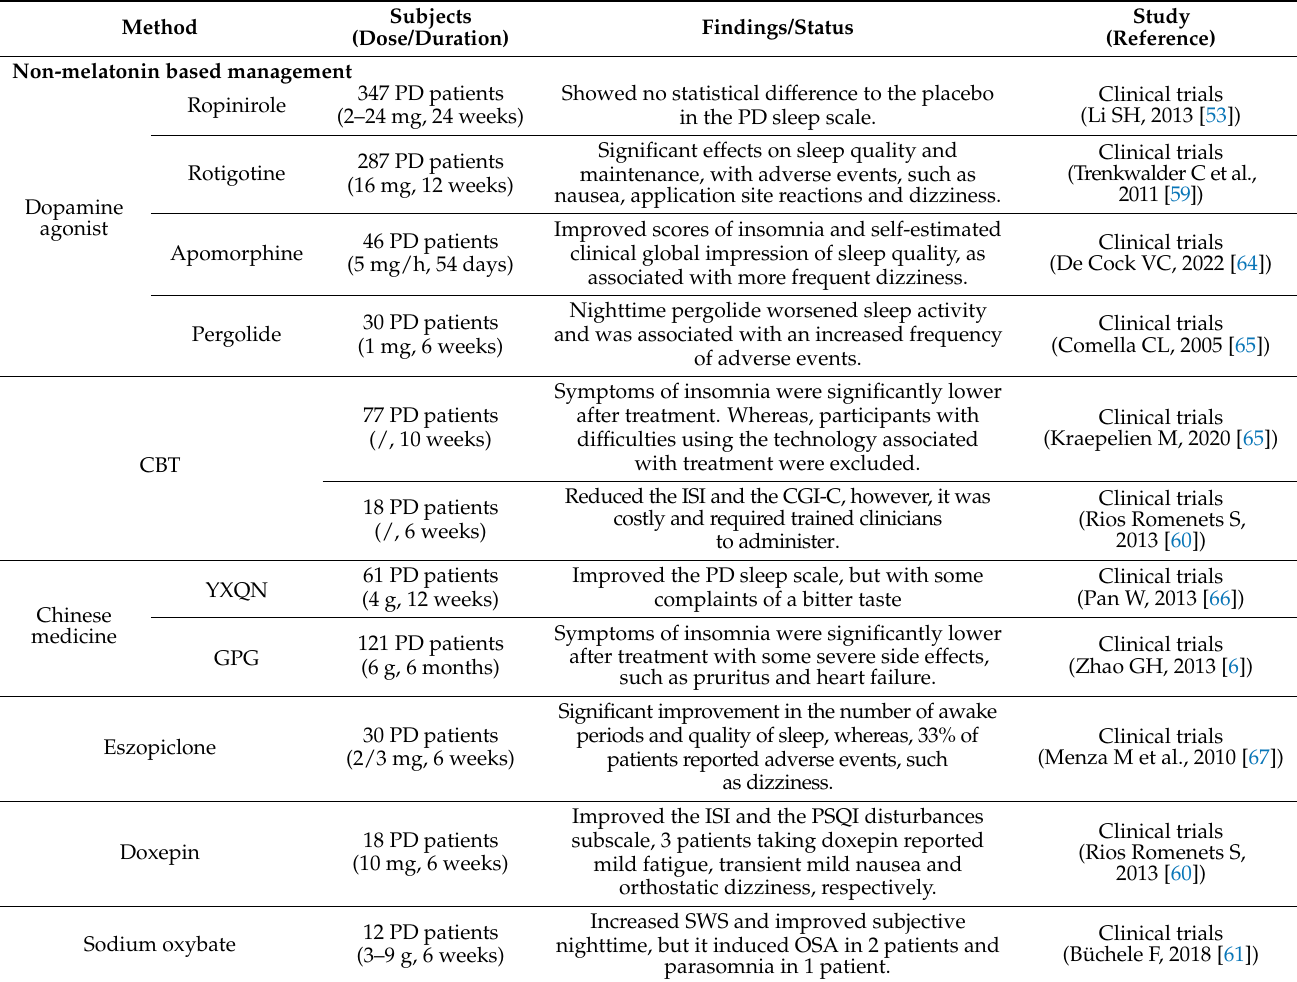
Table 2. Insomnia in Parkinson’s disease and their management supported by randomized con- trolled